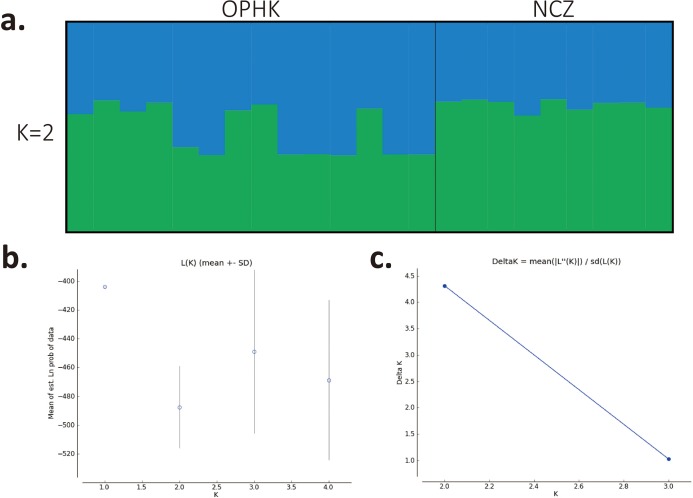
Population structure results for Blue-crowned Laughingthrush.(A) Each line represents one individual, and the proportion of population assignment of each individual in relative to each of given genetic cluster is represented by the length of each line. Abbreviations indicate different Blue-crowned Laughingthrush populations (OPHK, Ocean Park Hong Kong; NCZ, Nanchang Zoo). (B) Posterior probability means; Ln P(D) (±SD) increased per K. (C) The second order rate of change of the Ln P(D) with respect to the number of clusters was shown.